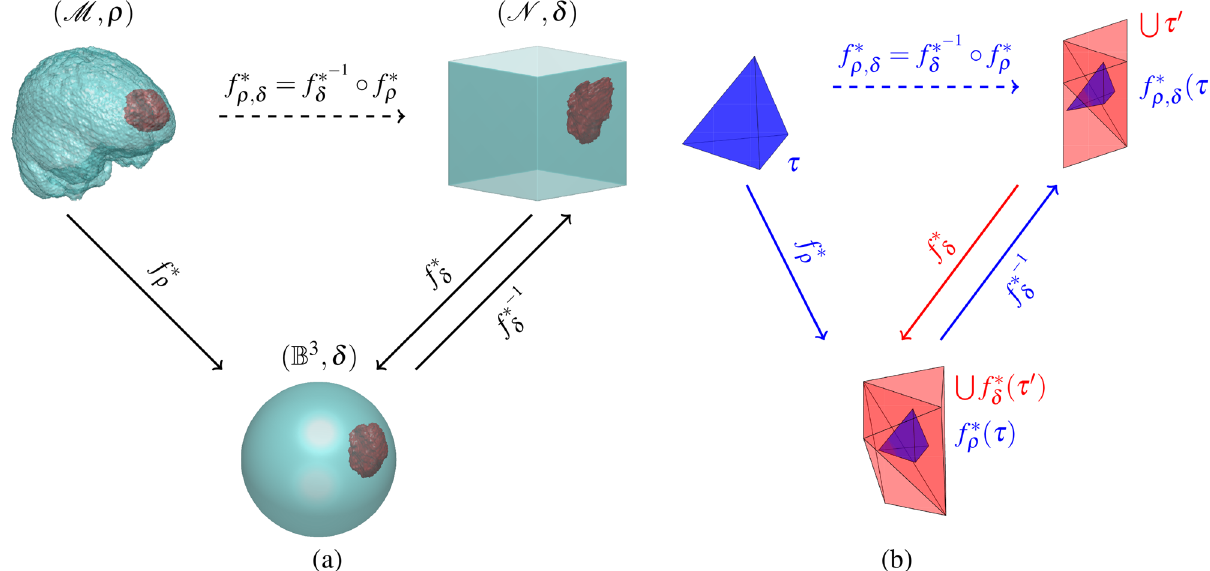
1 ) , Figure 1. ( a ) A diagram illustrating the construction of the TSOMT map f ∗ ρ , δ between ( M , ρ) and ( N , δ ≡ where M , N , and B 3 are a 3D brain image, a 3D solid cube, and a 3D unit solid ball, respectively. ( b ) The B 3 ) , T ( B 3 ) , f T ( M ) T N ) T τ f ∗ ρ (τ) f ∗ δ (τ ′ ) bijective and linear simplicial map f ∗ ρ ∗ δ : τ ′ ∈ ′ ( ′ ( ∈ : ∈ → → ∈ T ( M ) T ( N ) τ f ∗ ρ , δ (τ) and f ∗ ρ , δ : ∈ → ∈